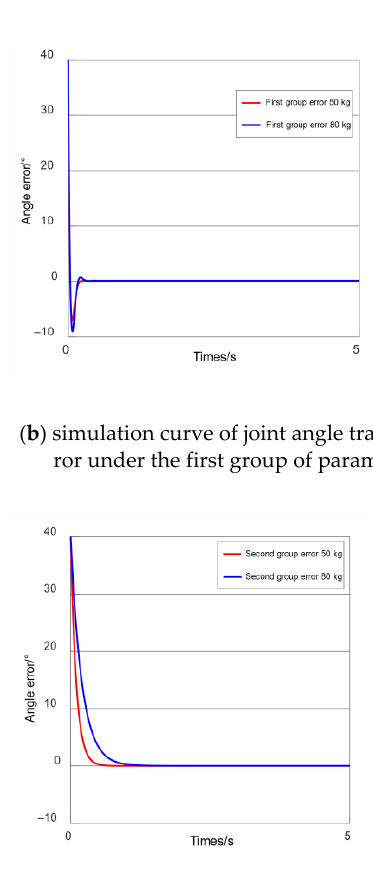
Figure 3. Simulation curve of ADRC tracking step input signal. Table 2. Parameters of PID controller simulation under step signal.